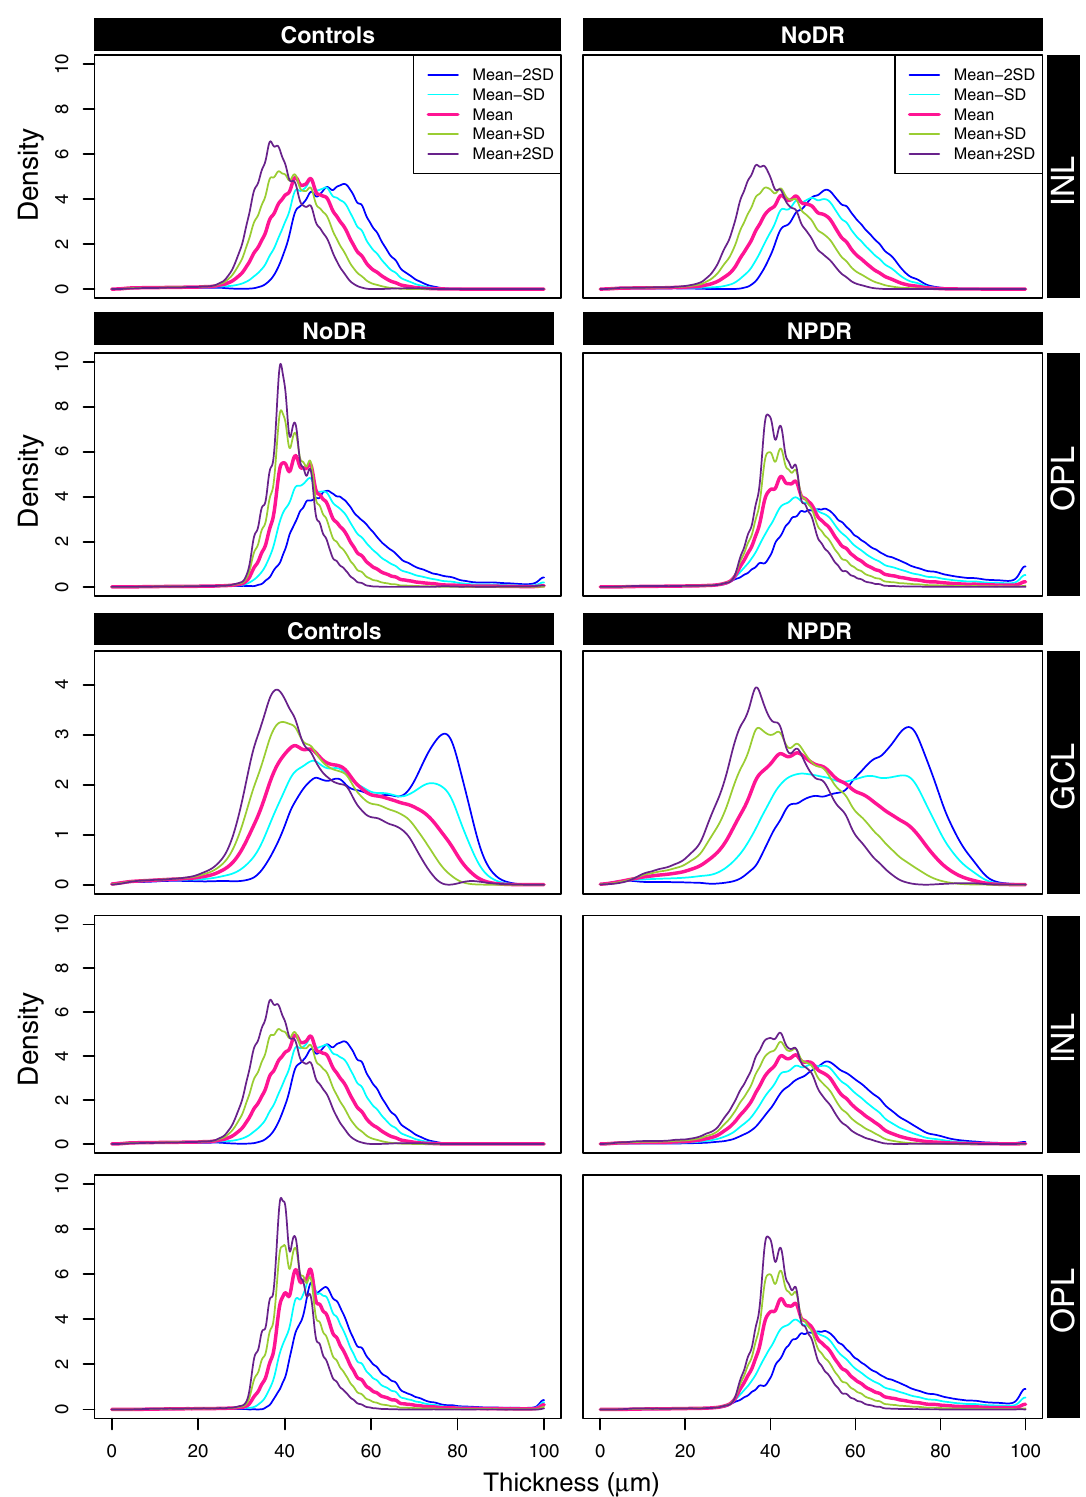
Figure 5. First principal direction of variability in a specific layer from a given group of subjects. In each case we present the path sampled with − 2, − 1, 0, + 1, + 2 standard deviations around the mean along the first principal component